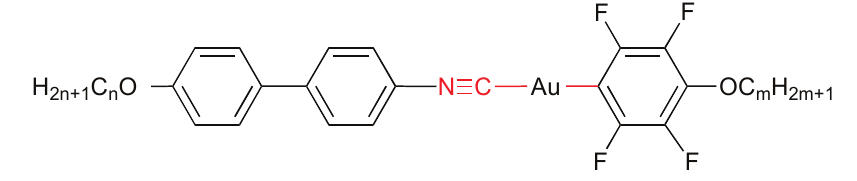
Figure 15. Binary mixture of copper and gold compounds. M = Au, Cu.